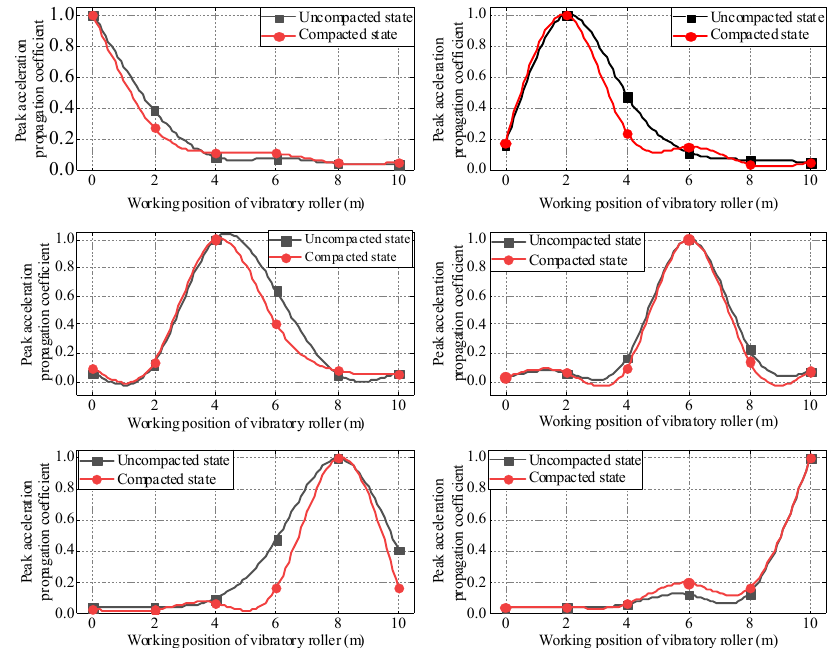
Figure 8. Peak acceleration propagation coefficient.